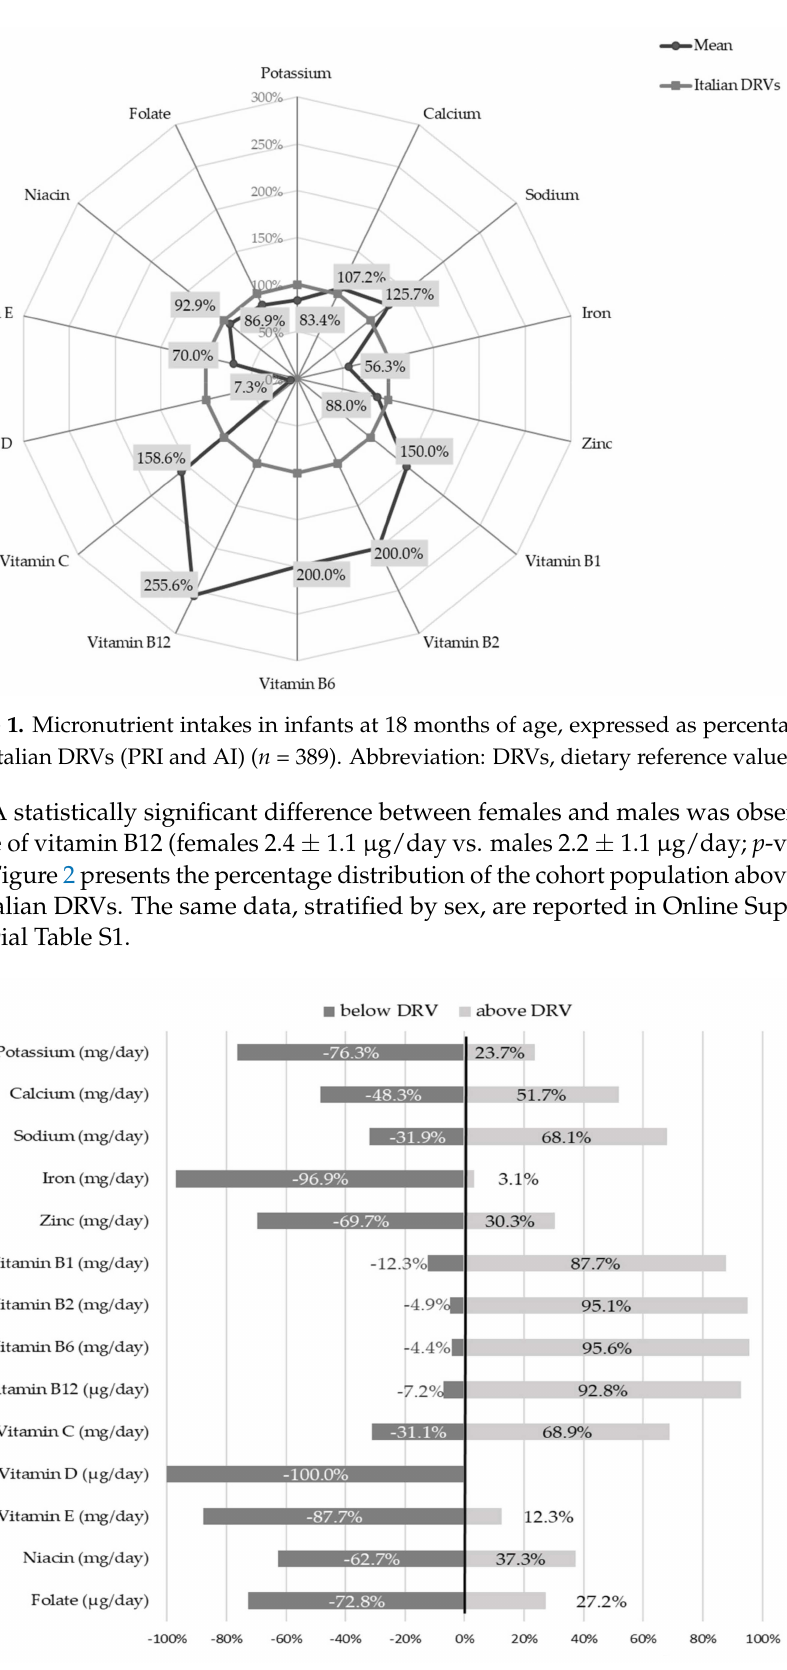
Figure 2. Adherence of the cohort population to Italian micronutrient DRVs ( n = 389). Abbreviation: DRV, dietary reference